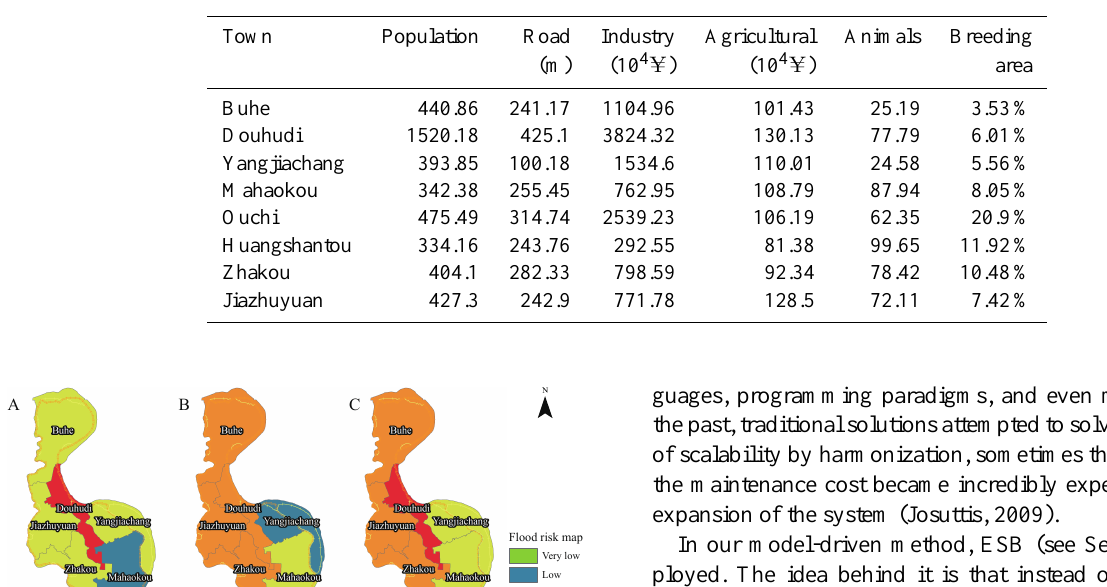
Table 2. Vulnerability characteristic within the unit area (e.g., 1km 2 ) .